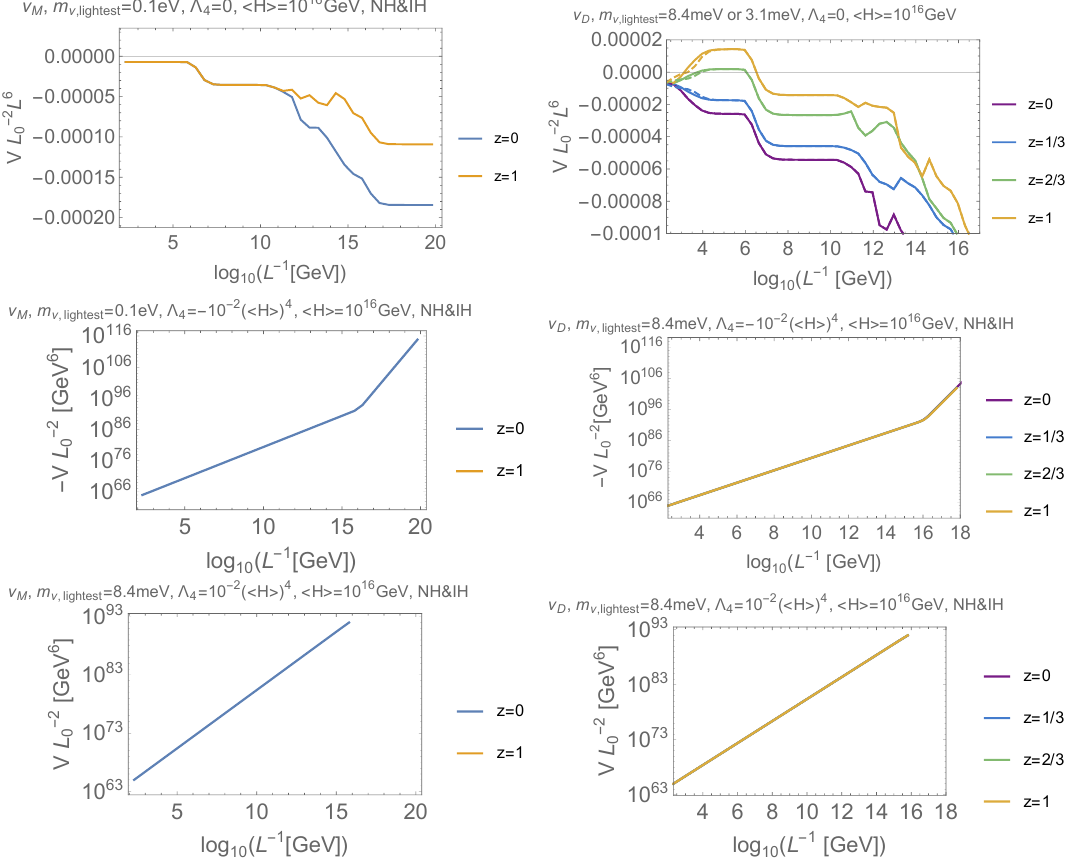
Figure 7 . Upper: S 1 compacti(cid:12)cation of the SM where (cid:3) 4 = 0 and h H i = 10 16 GeV. For (cid:23) D , the vacuum exists around L (cid:0) 1 (cid:24) 10 (cid:0) 3 GeV. Middle: S 1 compacti(cid:12)cation of the SM where (cid:3) 4 = (cid:0) 10 (cid:0) 2 h H i 4 and h H i = 10 16 GeV. For L (cid:0) 1 . 10 16 GeV, the main contribution is the cos- mological constant while the Casimir energy dominates for L (cid:0) 1 & 10 16 GeV. There are no vacua. Lower: the S 1 compacti(cid:12)cation of the SM where (cid:3) 4 = 10 (cid:0) 2 h H i 4 and h H i = 10 16 GeV. There are no vacua.